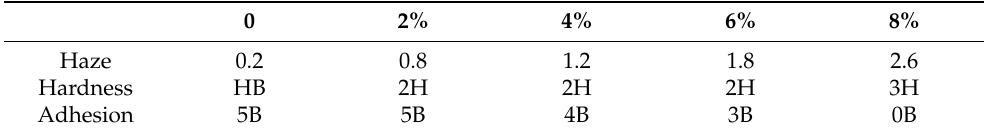
Table 1. Coating performance test.